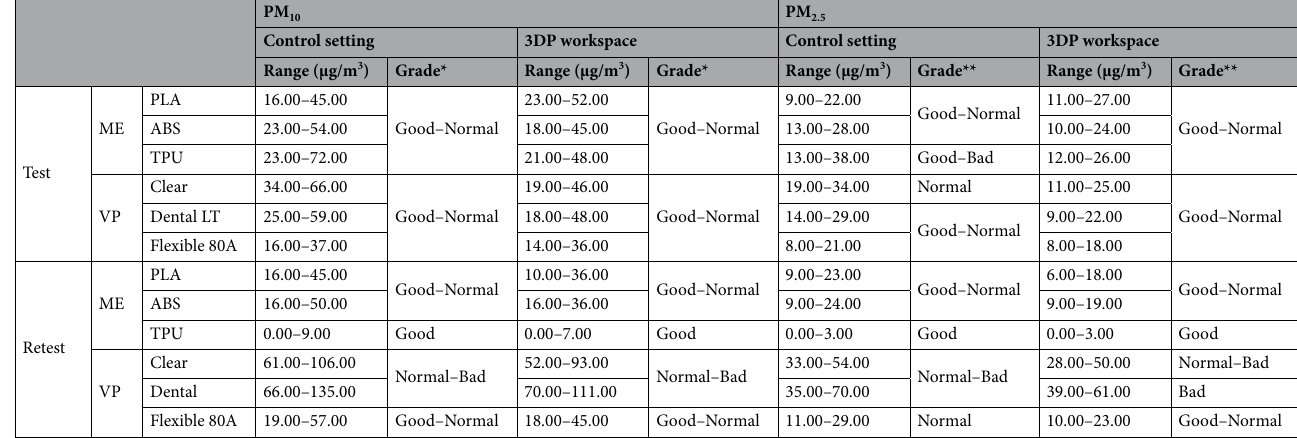
Table 2. The ranges and grades for the concentrations of PM 10 and PM 2.5 with ME and VP with test and retest. PM